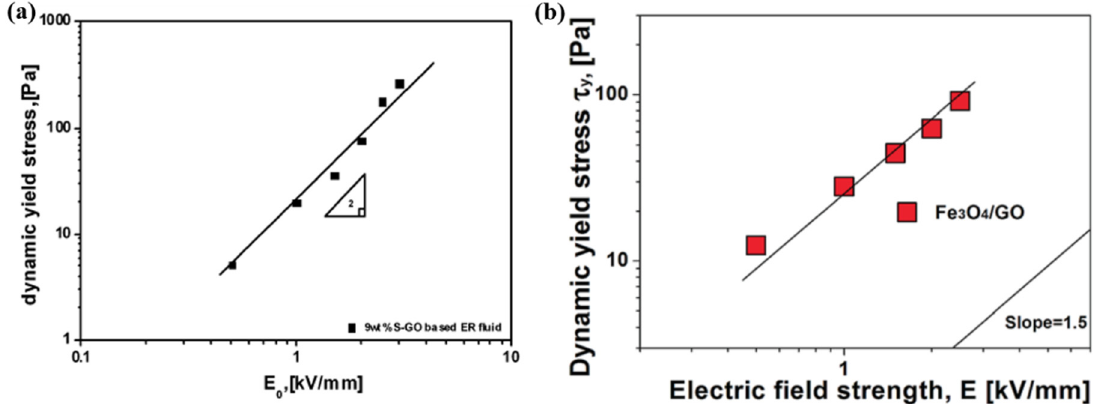
Figure 11. Dynamic yield stress as a function of the electric field strength for ( a ) Si-GO based ER fluid (9 wt.%) [66], ( b ) Fe 3 O 4 / GO based ER fluid (15 wt.%) (9 wt.%) [66], ( b ) Fe 3 O 4 /GO based ER fluid (15 wt.%) [55].